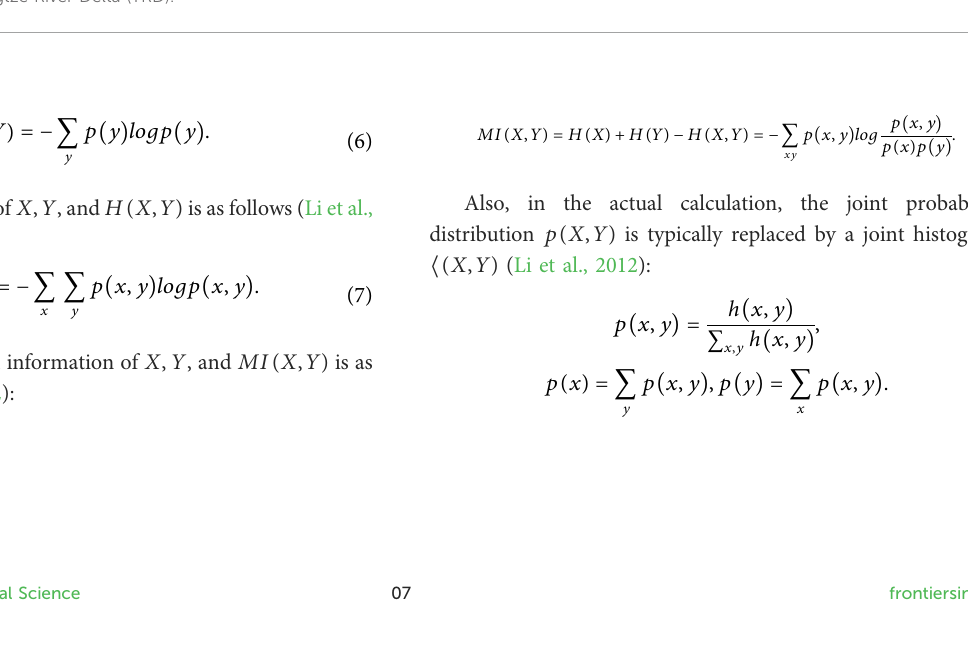
FIGURE 4 Spatial distributions of ground O 3 monitoring stations (blue dots) in 2021 across China, where the background is surface elevation (m). The uppermost, lowermost, and rightmost panels show the three regions of interest in this study: the Beijing – Tianjin – Hebei (BTH) region, Pearl River Delta (PRD), and Yangtze River Delta